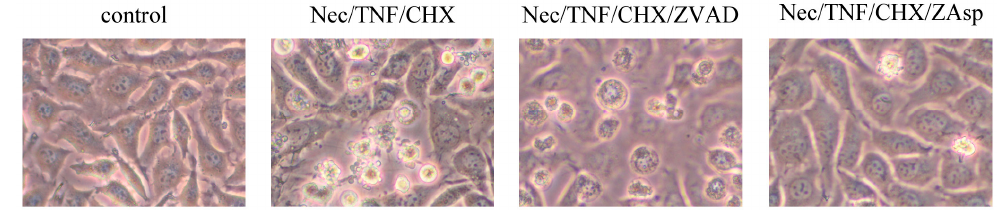
Figure 3. Induction of apoptosis in TNF-treated L929 cells in the presence of necrostatin-1 (phase-contrast microscopy, original magnification 400 × ). L929 cells were treated with 10 µ M necrostatin-1 (Nec), 10 ng/mL TNF, 10 µ g/mL cycloheximide (CHX) with or without 10 µ M Z-VAD-fmk (ZVAD) or 100 µ M Z-Asp-CH 2 -DCB (ZAsp) for 5 h. To confirm that apoptosis was induced in necrostatin-1/TNF/CHX-treated cells, the cells were